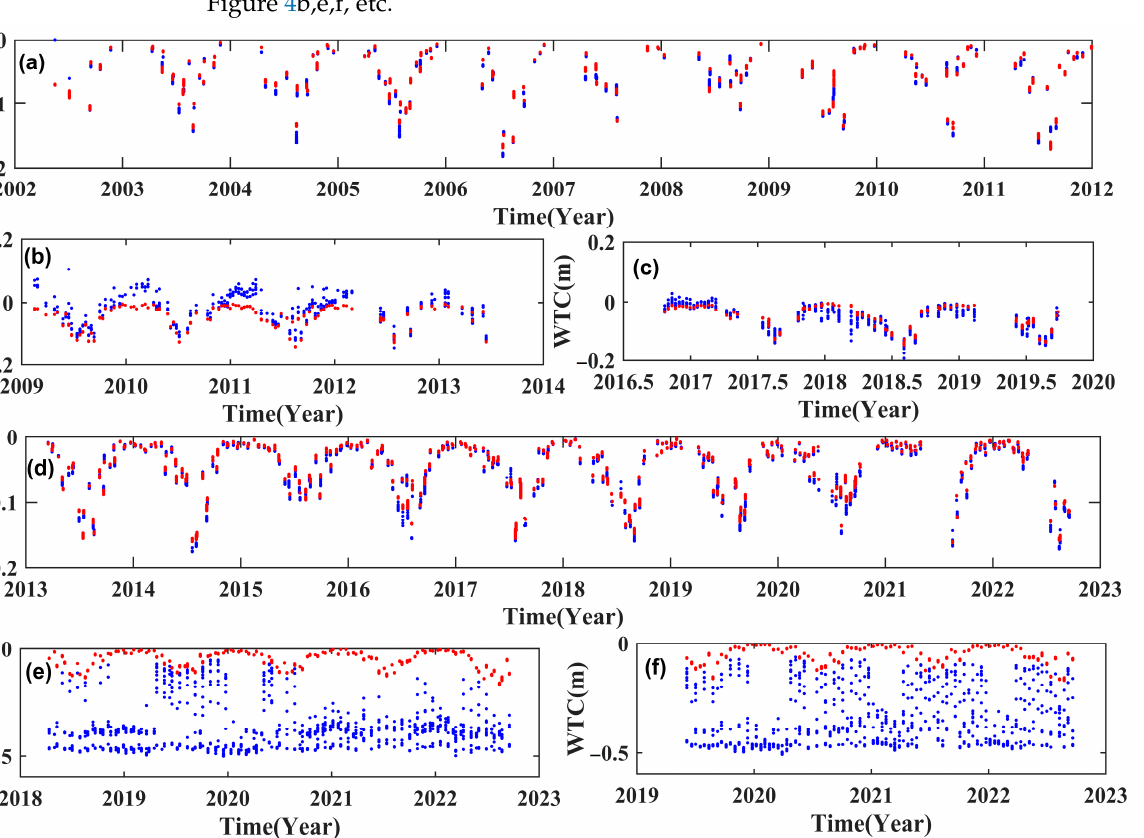
Figure 4. The comparison of the reprocessed WTC and products. ( a – f ) The Envisat RA-2, Jason-1, Jason-2, SARAL, Sentinel-3A SRAL, and Sentinel-3B SRAL satellites, respectively, until September 2022. Red represents the reprocessed data, and blue represents the product values.